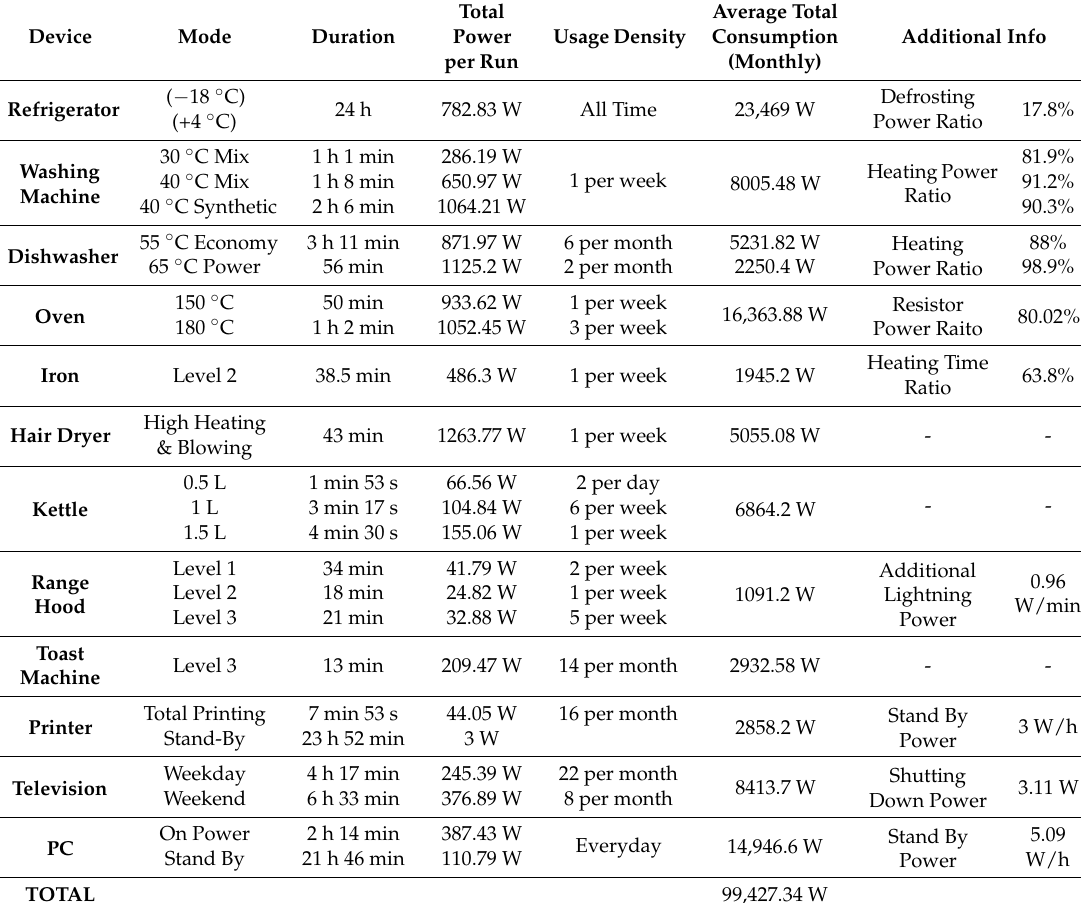
Table 2. Usage density and power consumption of household appliances for November